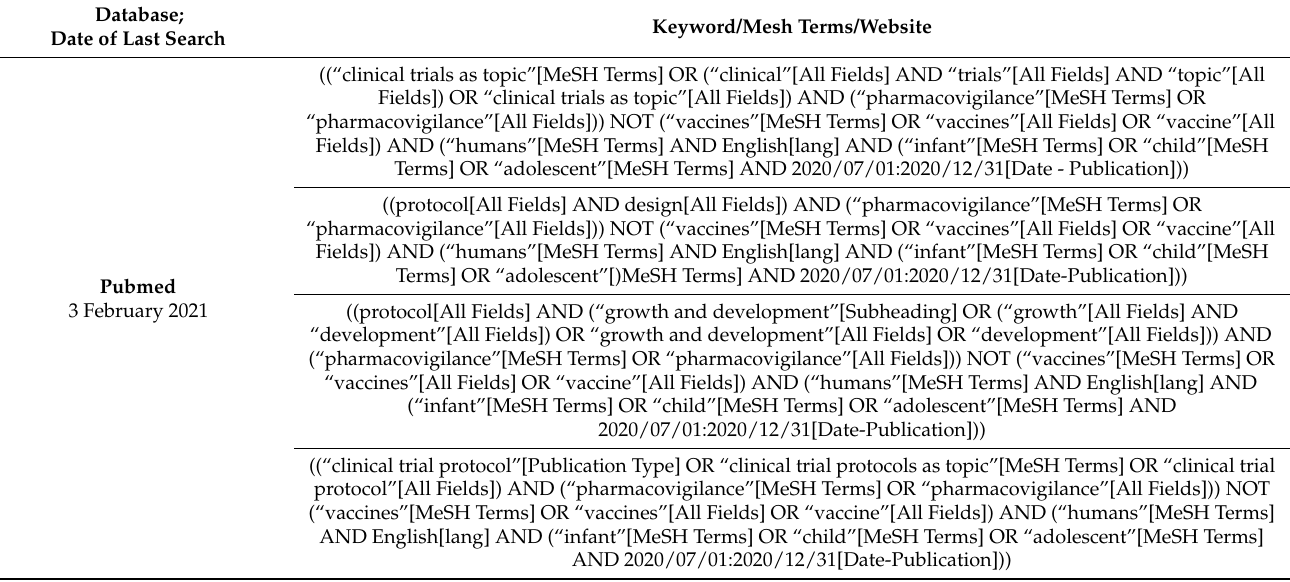
Table A1. Search